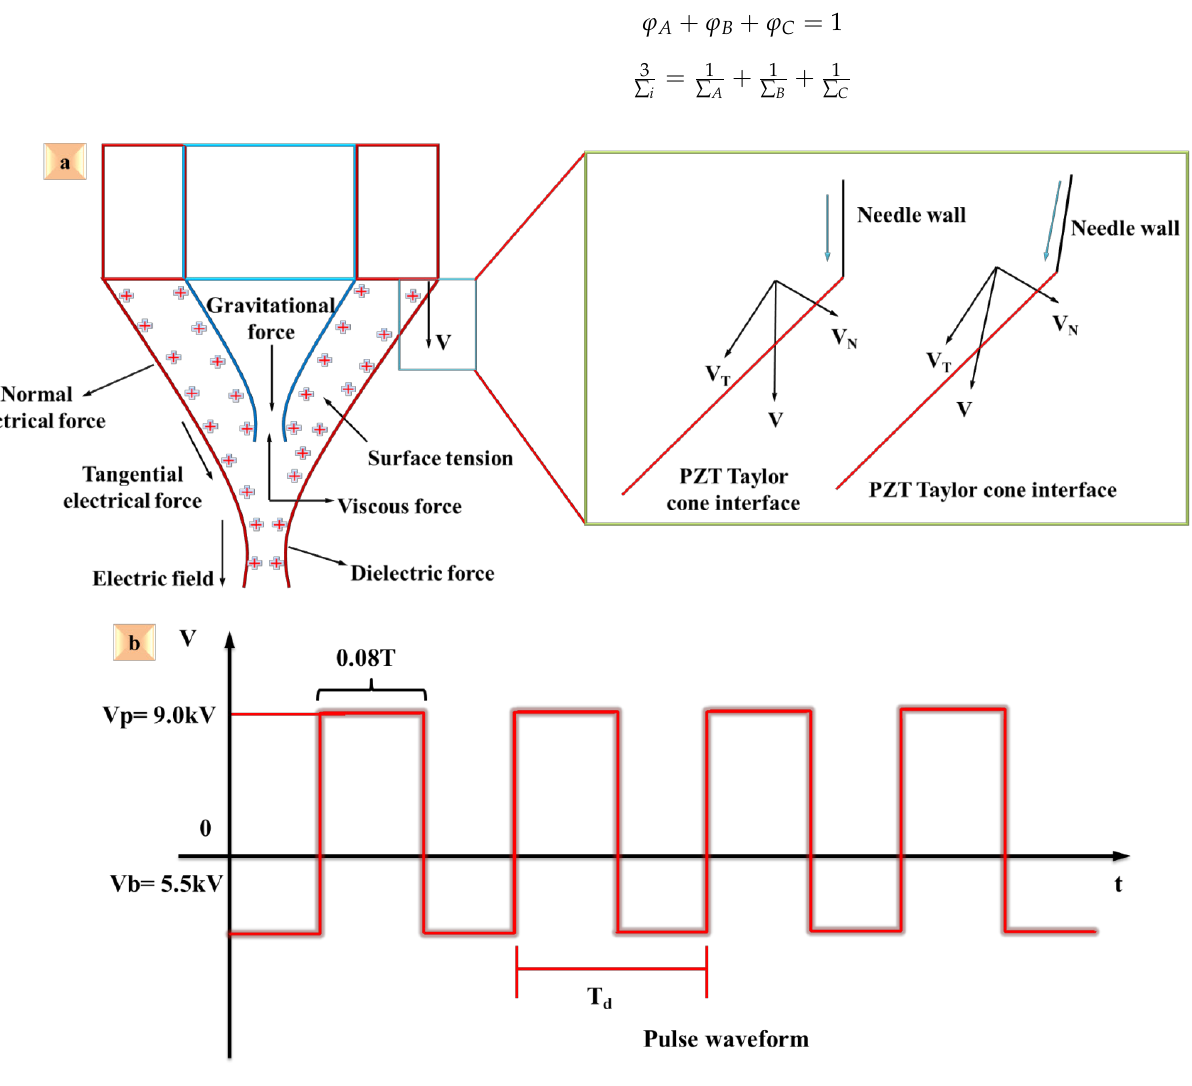
Figure 2. The effect of pulse waveform and analysis of different forces effect . ( a ) Forces acting around the needle tip in DoD coaxial E-Jet printing process . ( b ) The pulse waveform with different specific parameters such as base voltage, peak voltage, frequency , and duty cycle .